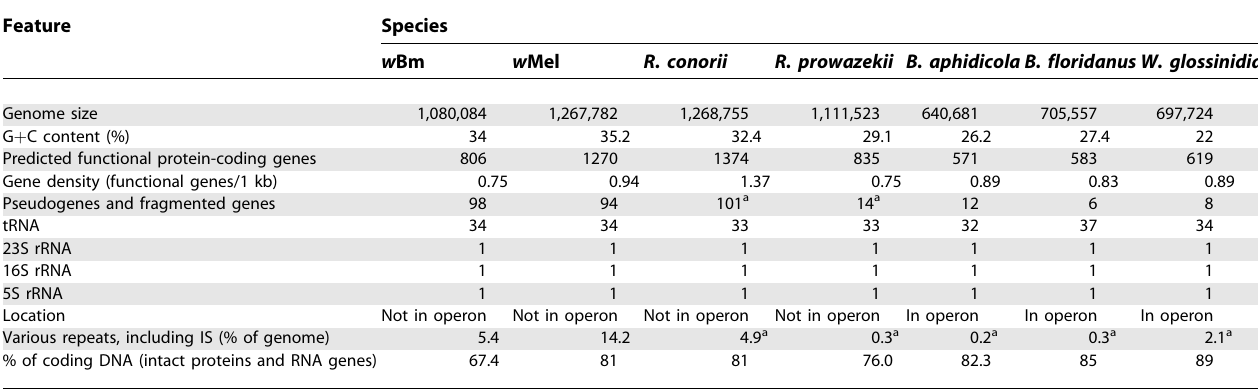
Table 1. Comparison of Genome Features of Proteobacterial Endosymbionts and Endoparasites Feature